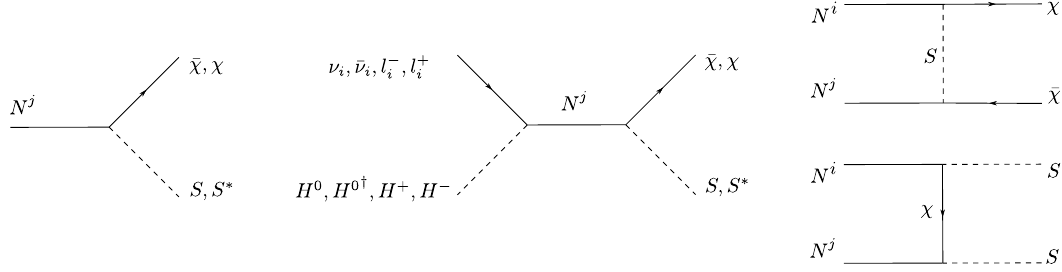
Figure 3 . Processes contributing to the freeze-in production of our dark matter candidate, con- sidered as either (cid:31) or S